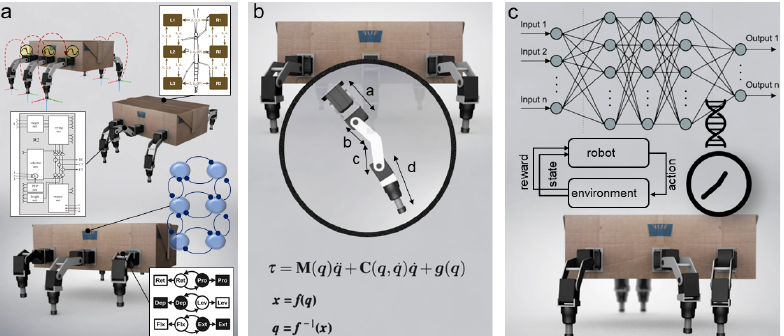
Figure 6. Different control approaches to robot locomotion. ( a ) Bio-inspired control. The upper-inset shows distributed decentralized CPGs with force feedback [158–160]. The middle inset shows the Walknet-control (modified from [143,161]). The lower inset shows the CPG-based control and a simpli- fied model with six oscillators for interlimb coordination (modified from [162,163]). ( b ) Engineering- based control [66,164]. ( c ) Machine learning-based control